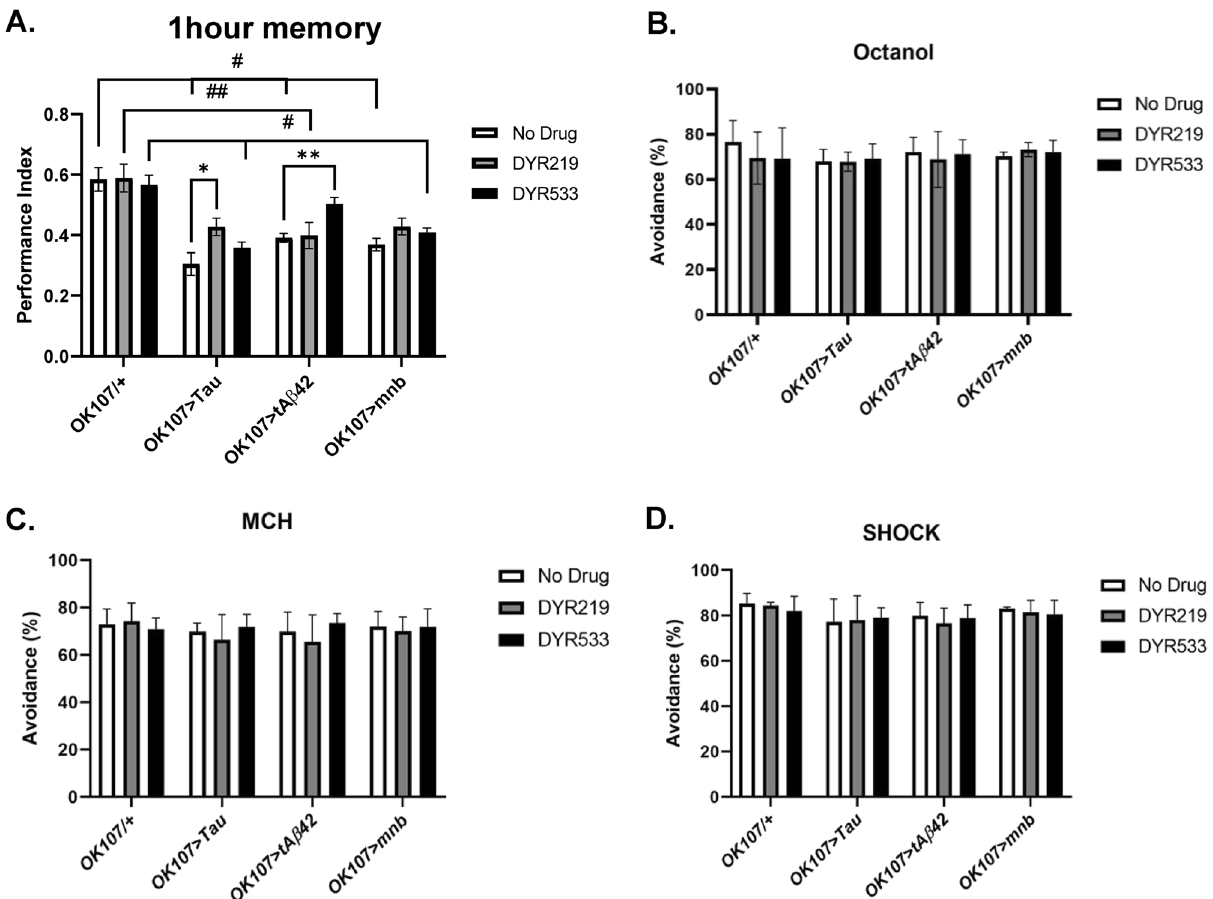
Figure 6. Mushroom body neuron overexpression of human Tau, tAβ42 and mnb cause memory deficits improved by DYRK1A inhibitors. ( A ) Overexpression of human tau, tAβ42 and mnb throughout the fly memory centre, the mushroom body ( OK107-Gal4 ) decreased 1 h memory (performance index (PI)) compared to OK107/ + control. DYR219 increased the memory performance of human Tau overexpressing flies and was able to completely rescue the memory loss of both human Tau and mnb overexpressors. DYR533 significantly increased the memory of human tAβ42 flies to a level indistinguishable than control. Data was analysed with 2-way ANOVA with Dunnett’s post hoc multiple comparisons test, * and # as listed in the Methods statistics section and previous legends. Mean PI was taken from four independent experiments. Neither mushroom body overexpression of mnb, human tAβ42 and human Tau or DYR219 or DYR533 treatment change the response of the fly to ( B ) octanol, ( C ) MCH or ( D ) shock compared to control. Average % avoidance was taken from 3–4 independent experiments with each n = 30–50 flies per experiment per